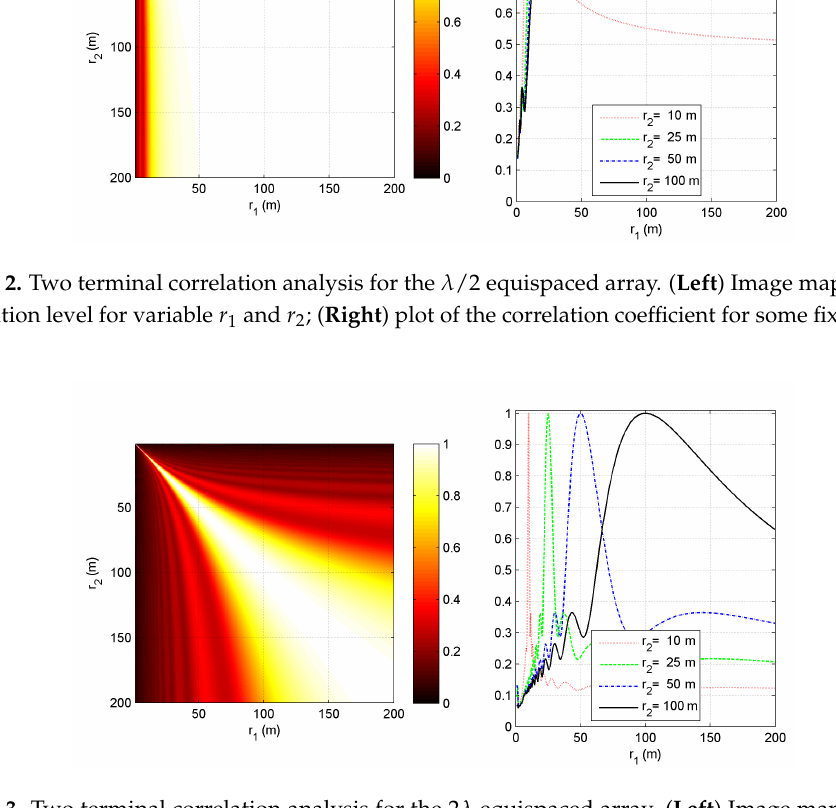
Figure 3. Two terminal correlation analysis for the 2 λ equispaced array. ( Left ) Image map with the correlation level for variable r 1 and r 2 ; ( Right ) plot of the correlation coefficient for some fixed values of r 2